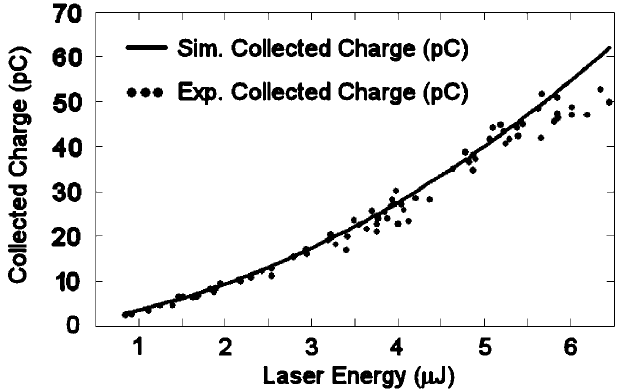
FIG. 5. Emission curve characteristic of this Mg film sample. The nonlinear correlation between bunch charge and laser en- ergy due to the non-negligible contribution of the two-photon electron emission process is